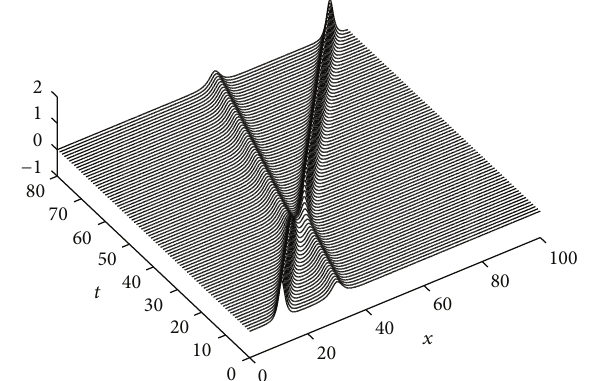
Figure 4: Numerical solution 𝑉 𝑛 with parameters 𝜆 1 = 1.0 , 𝜆 2 = = 10 , and 𝑦 = 30 . 0.6 , 𝑦 1 2